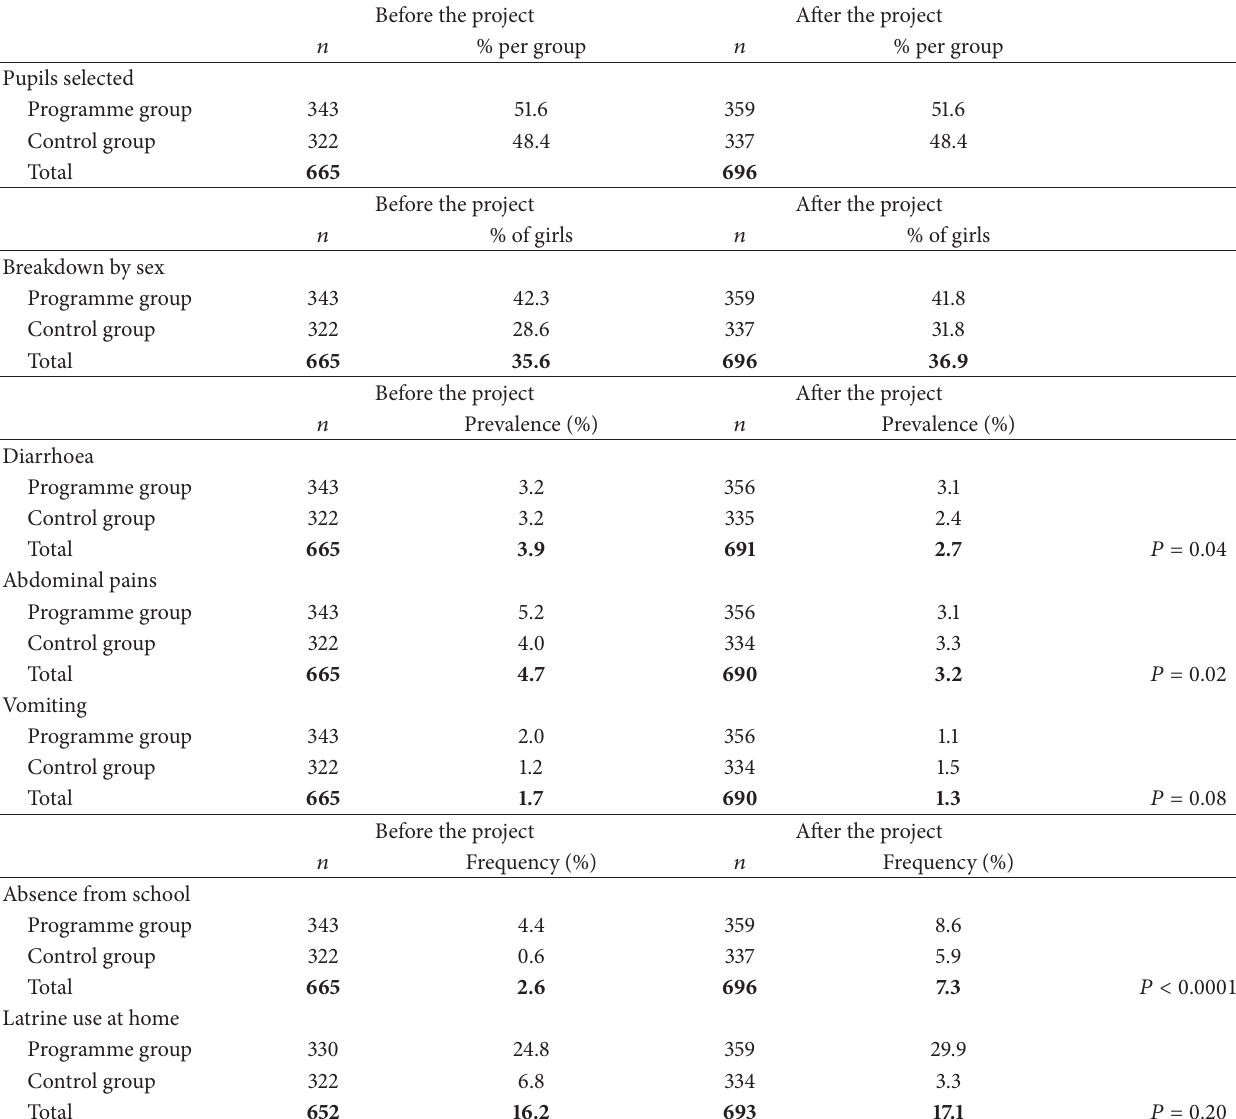
Table 2: Sex, frequency of functional signs due to lack of hygiene, absence from school, pupils’ hand washing, and latrine use before and after the project, Maradi,